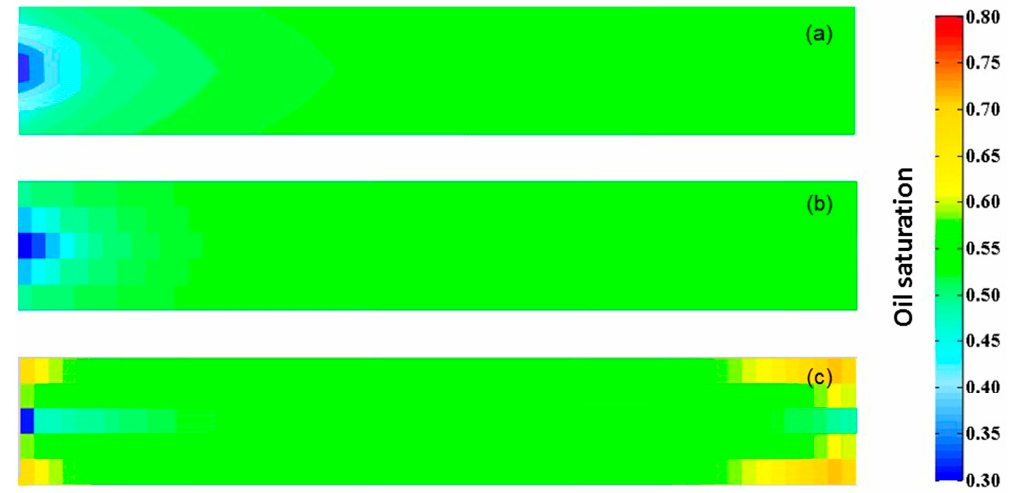
Figure 16. Oil saturation distribution when 10 PV water was injected: ( a ) by saturation detector, λ = 0.0005 MPa/m; ( b ) by designed simulator, λ = 0.0005 MPa/m; and ( c ) by the designed simulator, λ = 0.0750 MPa/m.